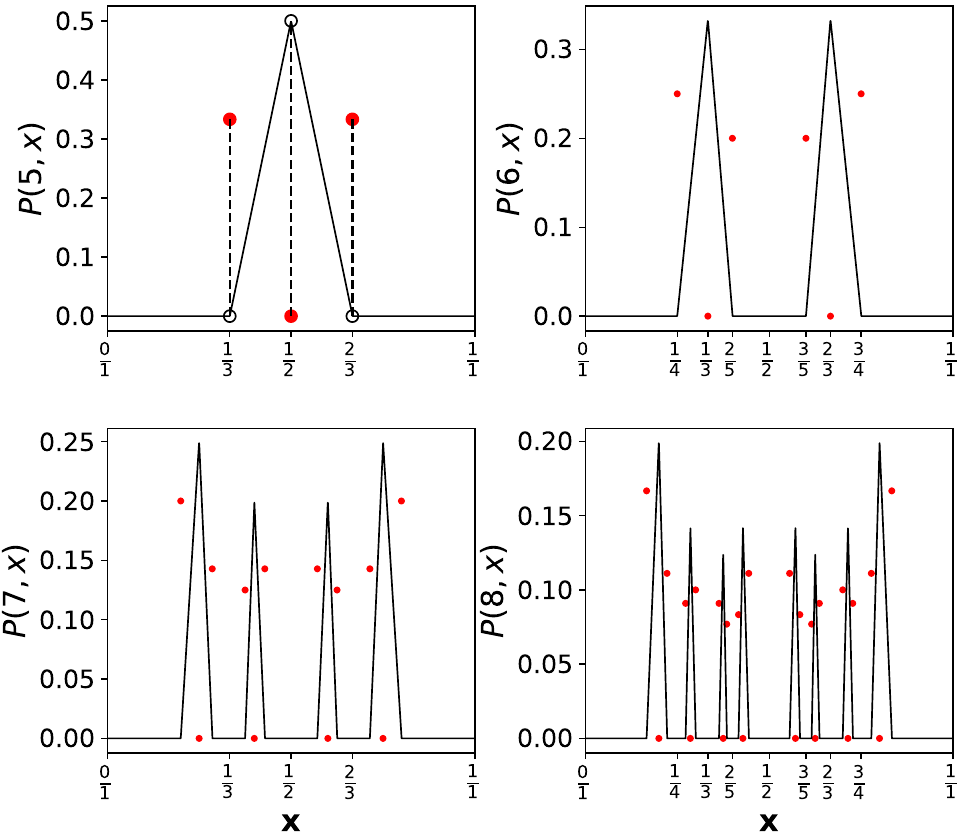
Figure 3. The numerical computation of the degree distribution P ( k , x ) as a function of x for k = 5,6,7,8, and for all Haros graphs G x with x ∈ F 1000 . The red points represent removable discontinuities, whereas the solid black lines shows the piecewise linear behavior. Due to the lack of space, only the left upper panel of P ( 5, x ) accurately shows that the red points represent the Haros graph located in levels (cid:96) κ , for κ = 5 − 3 = 2, i.e., the Haros graph G 1/2 (without nodes of degree k = 5), and for κ = 5 − 2 = 3, i.e., the Haros graphs G 1/3 , G 2/3 , where the degree k = 5 is located at the boundary